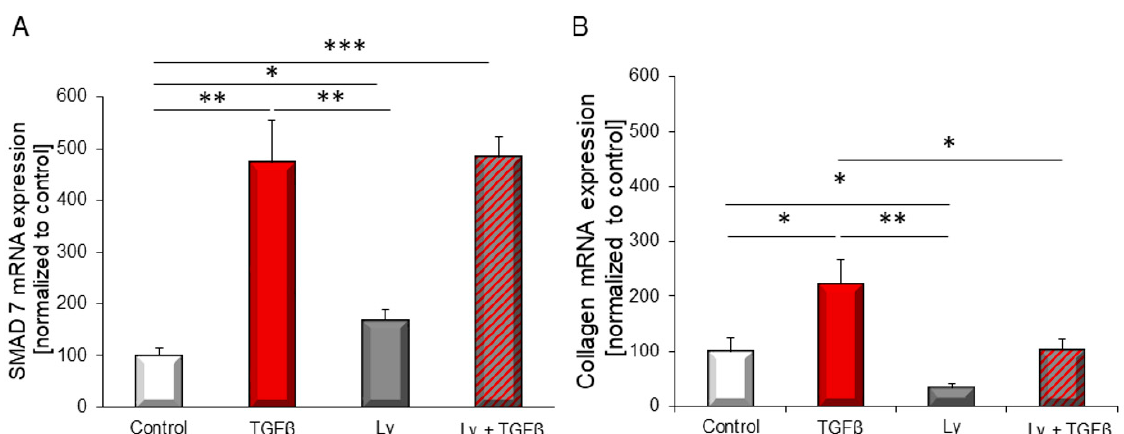
Figure 3. mRNA expression of TGF β 1 target genes ( A ) SMAD7 , ( B ) collagen 1 was determined with and without addition of PI3K inhibitor Ly294002 (10 µM) after 24 h stimulation with 1 ng/mL TGF β 1 . Gene expression was normalized to bestkeeper (18sRNA + B2M for SMAD7 , B2M + GAPDH for collagen 1 ). Data are shown as means ± SEM of seven different rat cardiomyocytes preparations. Significance is indicated by * p < 0.05, ** p < 0.01 and *** p < 0.001.